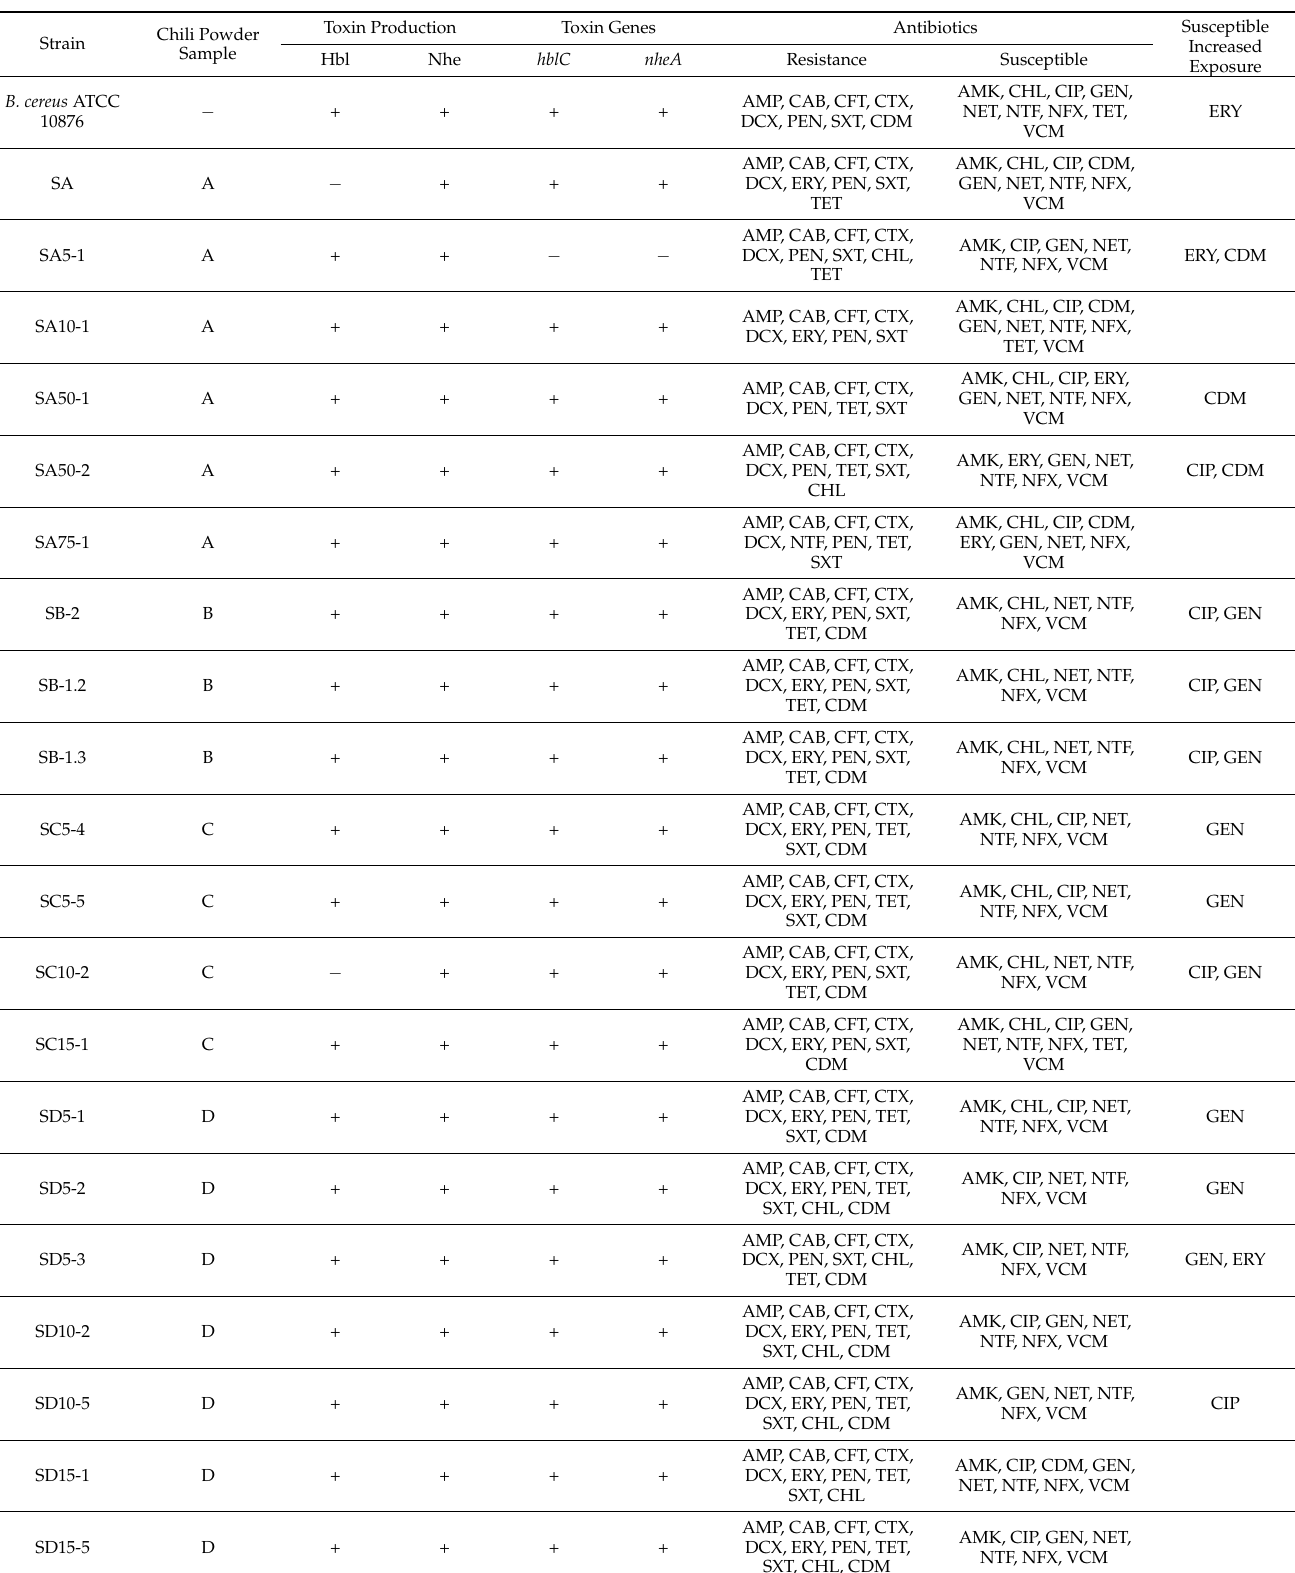
Table 2. Toxigenic and antibiotics characteristics for B. cereus s.l isolates from Mexican chili powder samples. Presence (+) or Absence ( − ) for toxin production and toxin